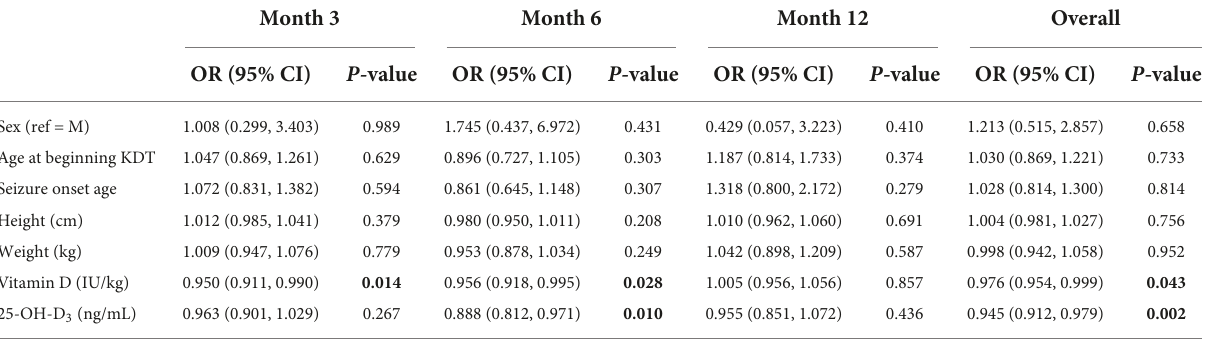
TABLE 3 Odds ratio of factors related to the occurrence of hypercalciuria.